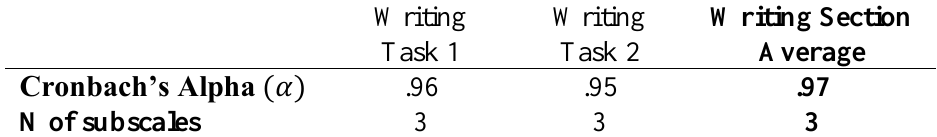
Internal Consistency Reliability for CLP Placement Test - Writing Section